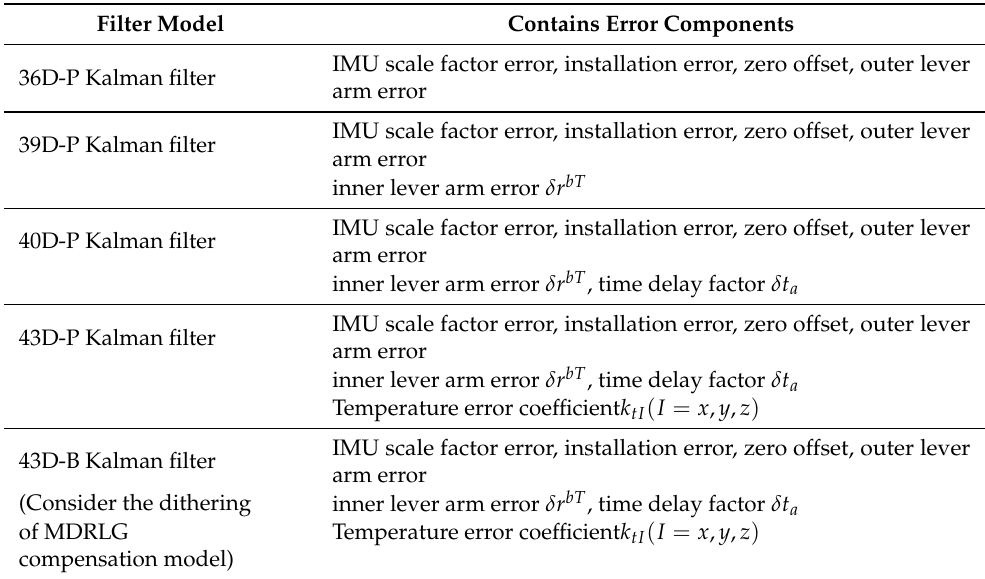
Table 3. Each Kalman filter model contains error